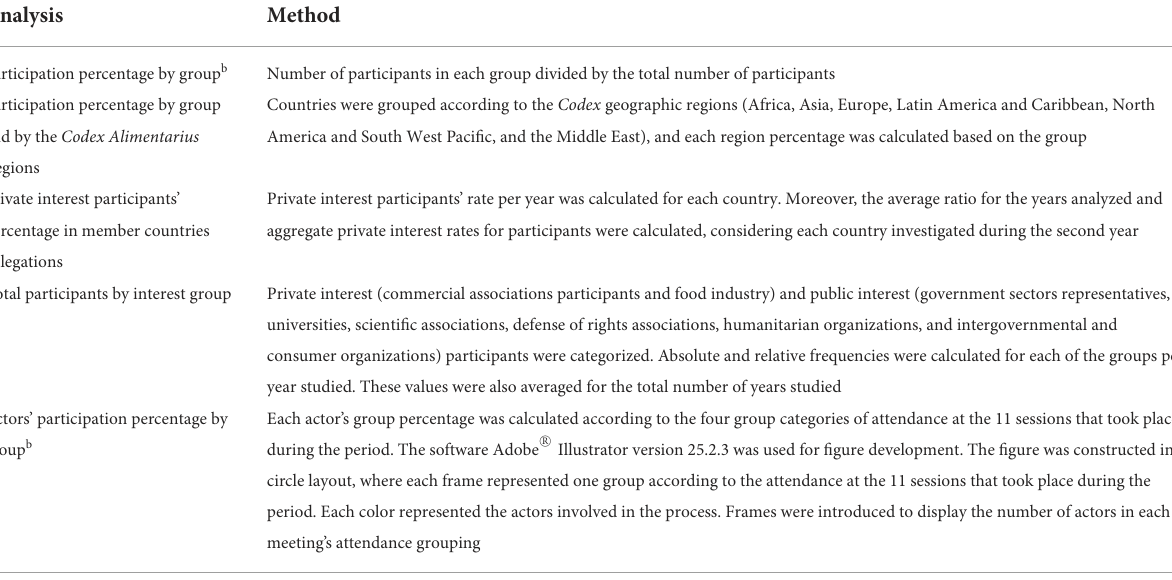
TABLE 1 Description of the methods adopted to analyze CCNFSDU a